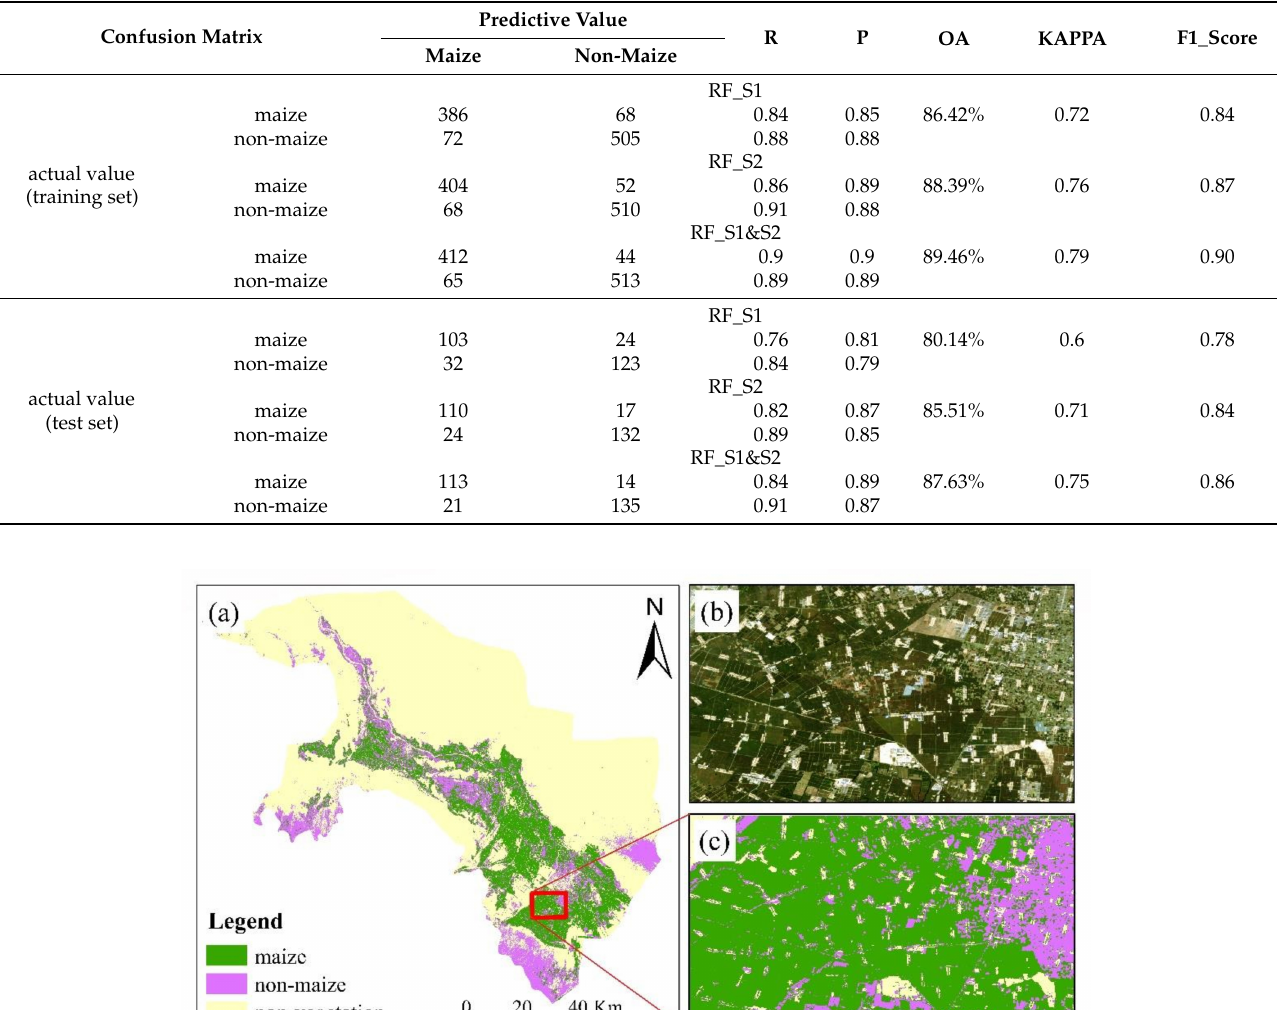
Table 2. The performance quantitative evaluation results of RF_S1, RF_S2 and RF_S1&S2 for training set and test set for using S1 (alone), S2 (alone) and combination of S1 and S2.